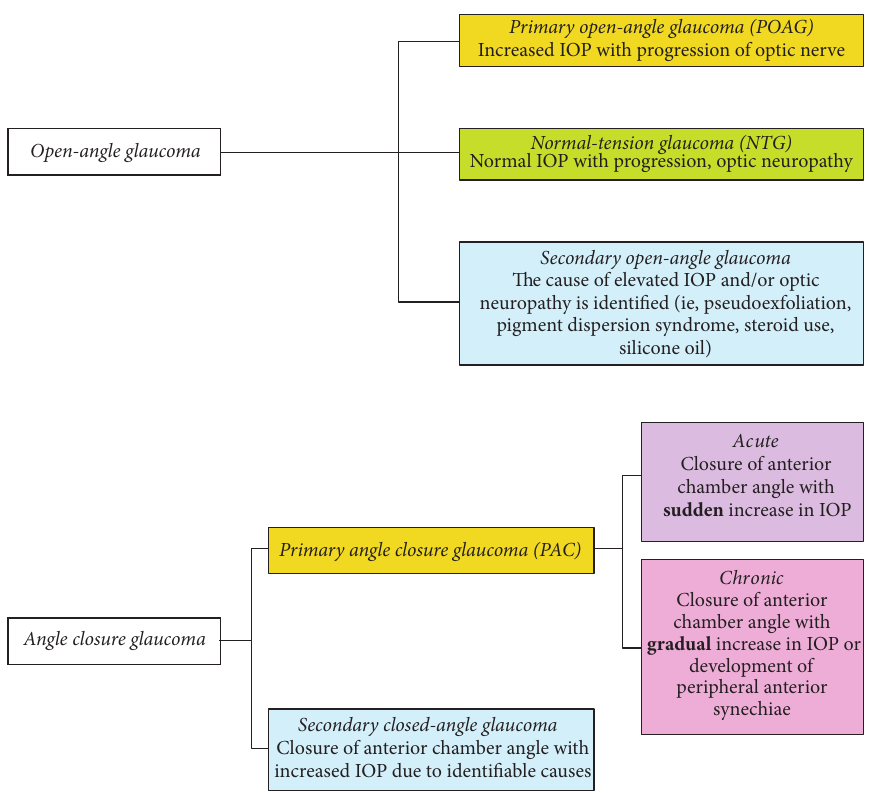
Figure 1: Glaucoma classification and